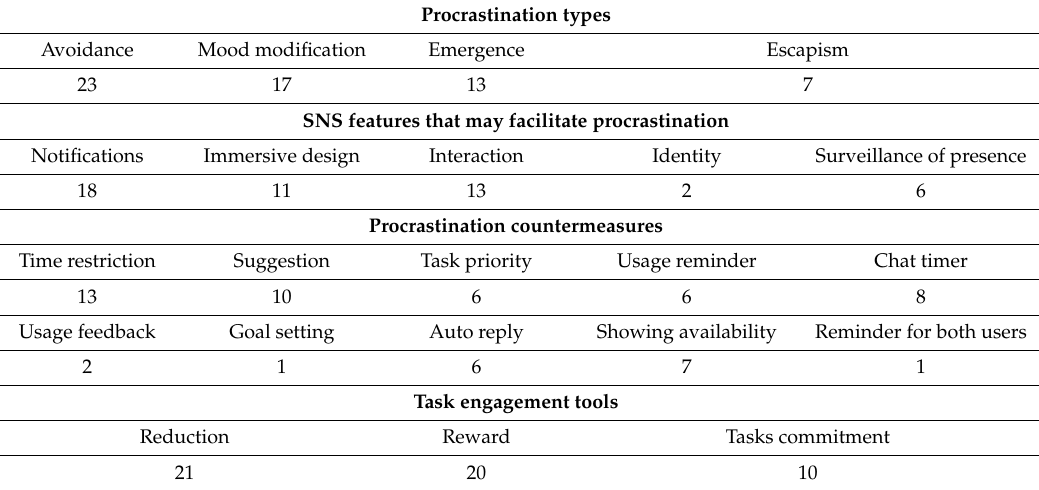
Table 11. Participants’ selection for procrastination types, triggers, and